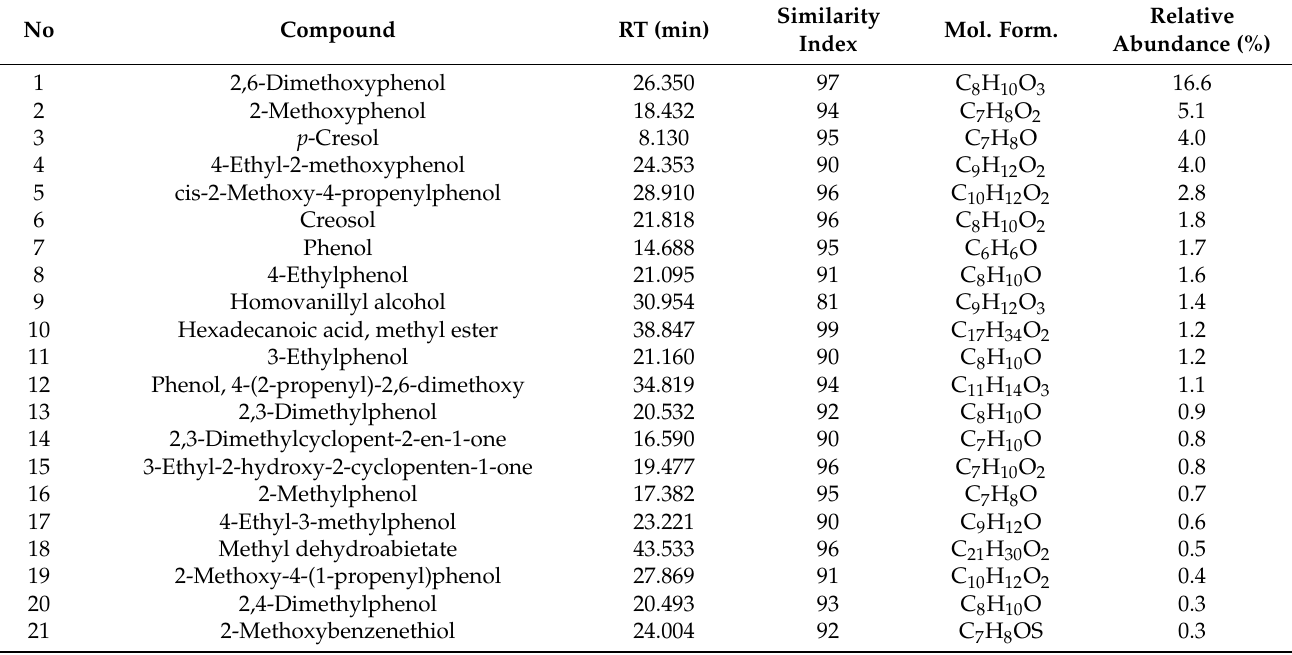
Table 6. Chemical composition of hemp roots (RT1) distillates from pyrolysis stage (PS) condensed at 130 ◦ C and analyzed by GC-MS.